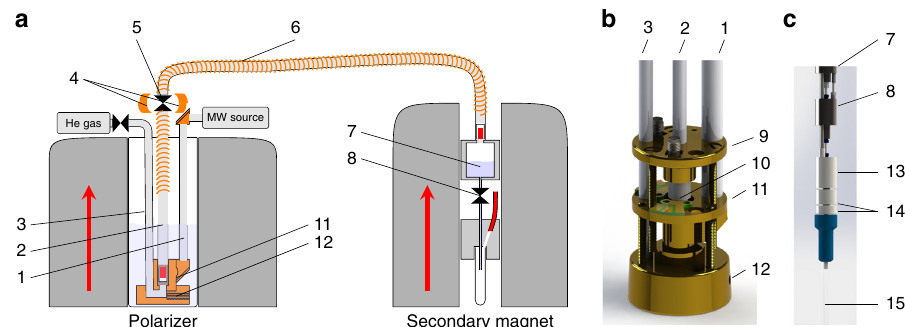
Fig. 1 Bullet-DNP equipment. a Sketch of the overall setup, comprising a polarizer magnet with cryostat and DNP insert, a transfer tube (6) with a solenoid along its entire length, and an injection device inside a liquid-state NMR magnet. The polarity of the superconducting magnets is indicated by the red arrows. The direction of the applied pulsed magnetic fi eld along the transfer changes at the valve (5), where two orthogonal pairs of Helmholtz coils (4) are used to rotate the fi eld. b Rendering of the lower part of the DNP insert showing the drive gas tube (3) on the left, the main sample tube (center, 2) and the microwave tube (1). The central brass piece (11) hosts small circuitboards for tuning and matching. SMA connectors are soldered to the top brass piece (9) that also pushes the coil support (10) onto the bottom brass piece (12) to seal the transfer path. c Rendering of the lower part of the injection device with a mounted NMR sample tube. The bottom of the solvent reservoir (7) can be seen at the top of the image, followed by the pinch valve (8) and a 3D printed nylon piece (13) with an internal channel that connects a 3/16 ” steel tube to the NMR sample tube to facilitate evacuating the latter. Two further nylon pieces (14) are screwed onto the NMR tube (15) using a compression fi tting, and facilitate a fast exchange of NMR tubes in between